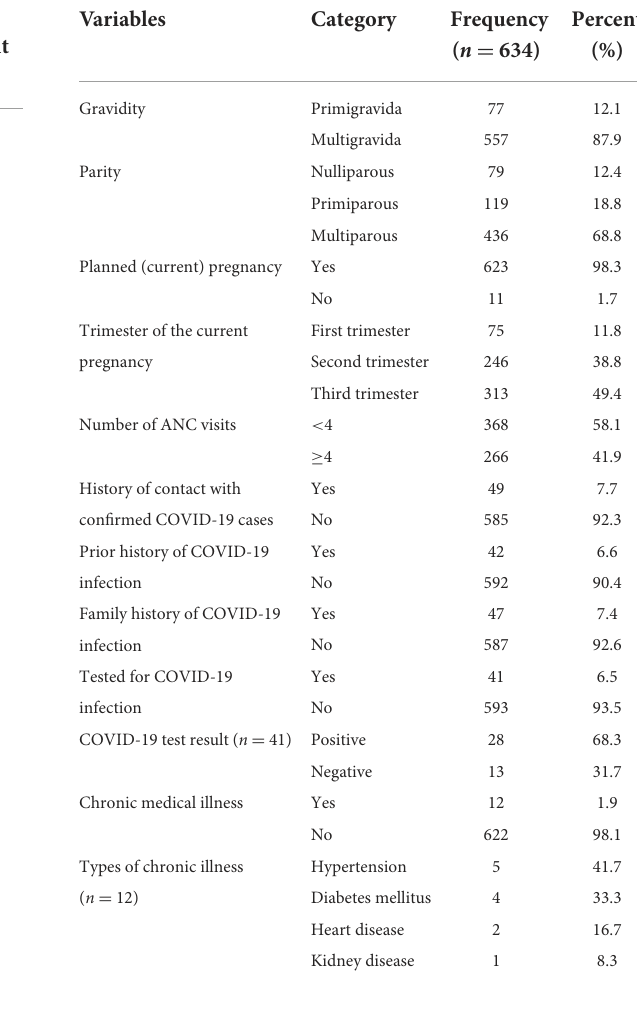
TABLE 1 Socio-demographic characteristics of pregnant women attending antenatal care in Debre Tabor public health institutions, Northwest Ethiopia,